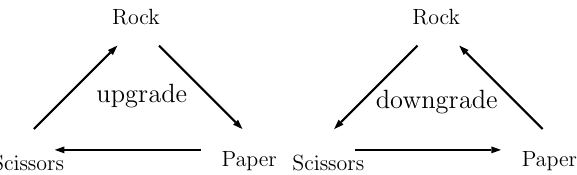
Figure 1. The coded cyclic strategies of upgrade ( left ) and downgrade ( right ) that represent consecutive choices. Upgrade refers to the subsequent t + 1th choice that beats the previous t th choice (e.g., rock-paper) and downgrade refers to the subsequent t + 1th choice that is beaten by the previous t th choice (e.g., paper-rock), based on each player’s self choice.